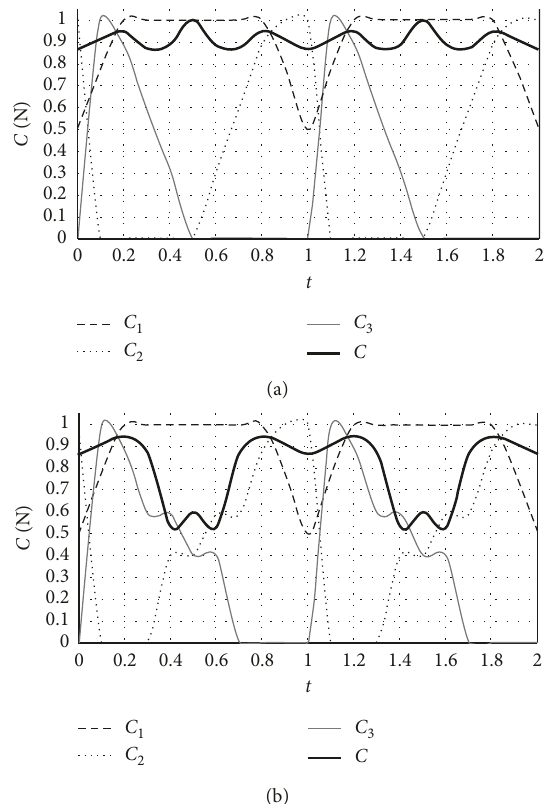
Figure 9: Graph of calculated equivalent contact forces when rotation of the sphere about the z axis is simulated. (a) C ∈ [ 0 , 1 ] N. (b) C ∈ [ 0 . 4 , 1 ] N.